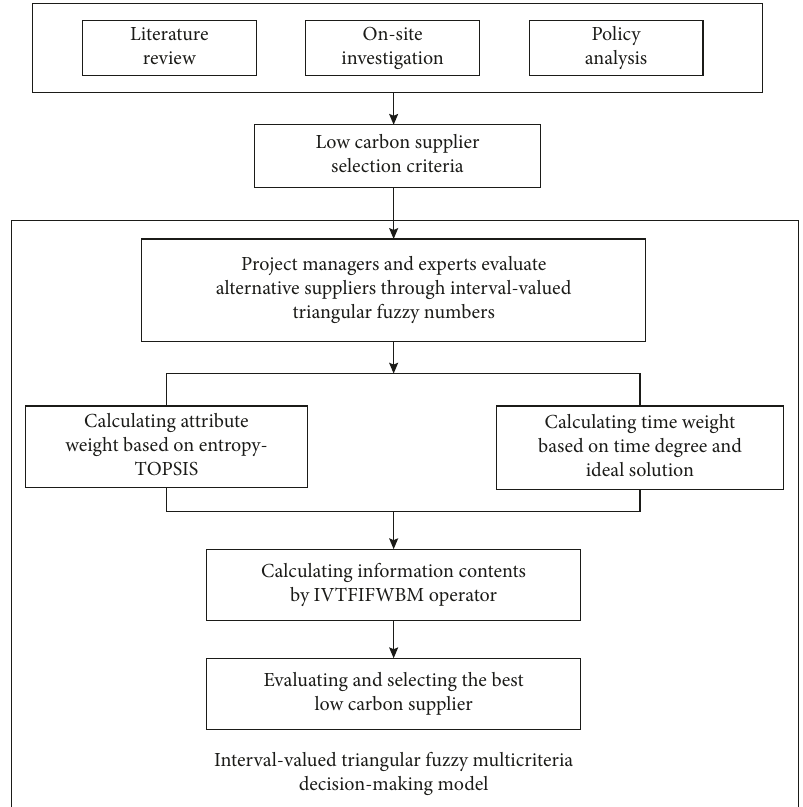
Figure 1: Methodological framework for low-carbon supplier evaluation and Table 1: Criteria for low-carbon supplier selection in the process of low-carbon building construction projects. Criteria